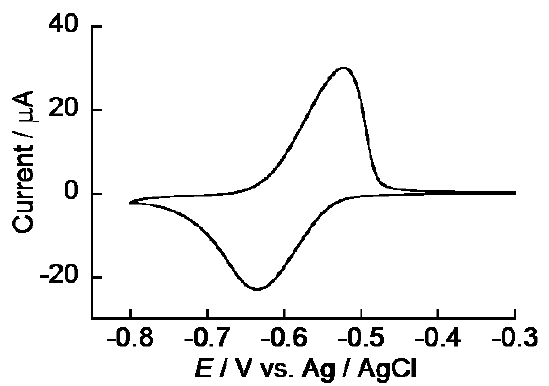
Figure 3. Typical CV of the Au electrode coated with ARS-immobilized (PEI/CMC) 10 PEI film recorded in 10 mM HEPES buffer at pH 7.5. Scan rate, 50 mV·s − 1 .